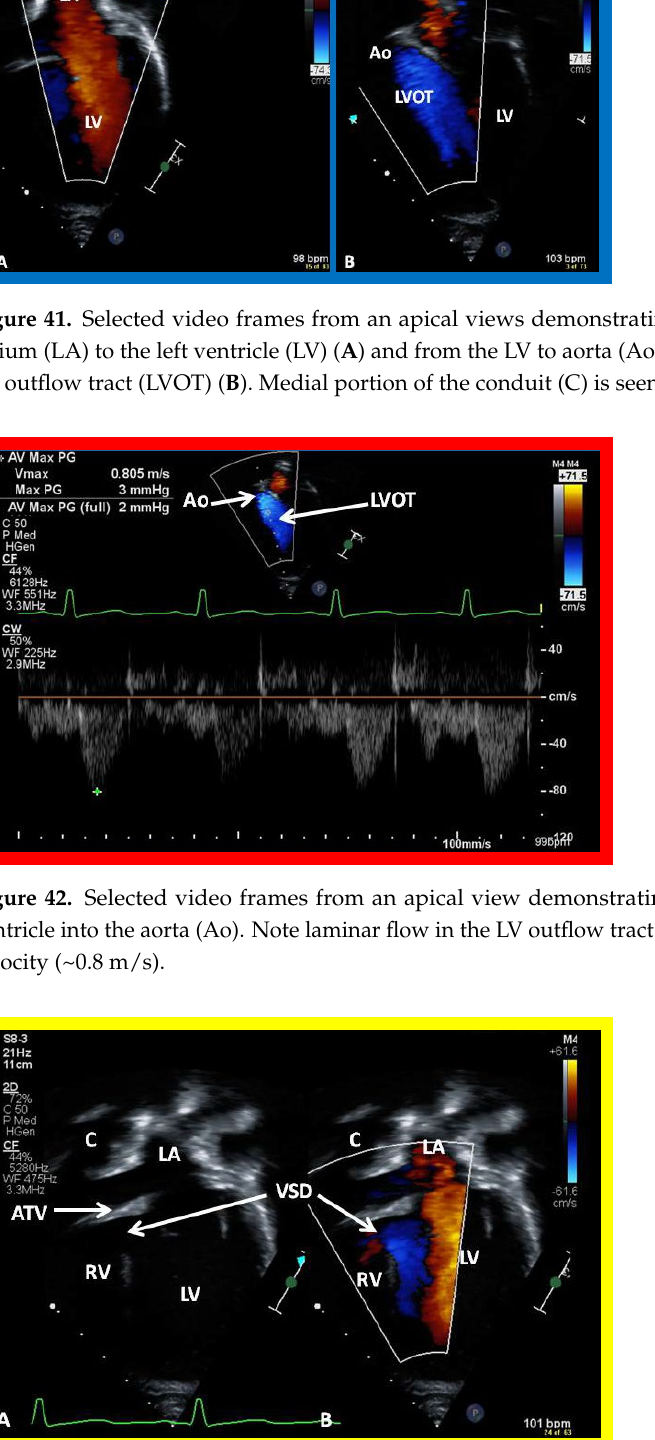
Figure 43. Selected video frames from apical views in two dimensional ( A ) and color flow imaging ( B ) modes demonstrating the right ventricle (RV) forming a cul-de-sac connection via a ventricular septal defect (VSD) with the left ventricle (LV). ATV, atretic tricuspid tricuspid valve, C, conduit, LA, left atrium.